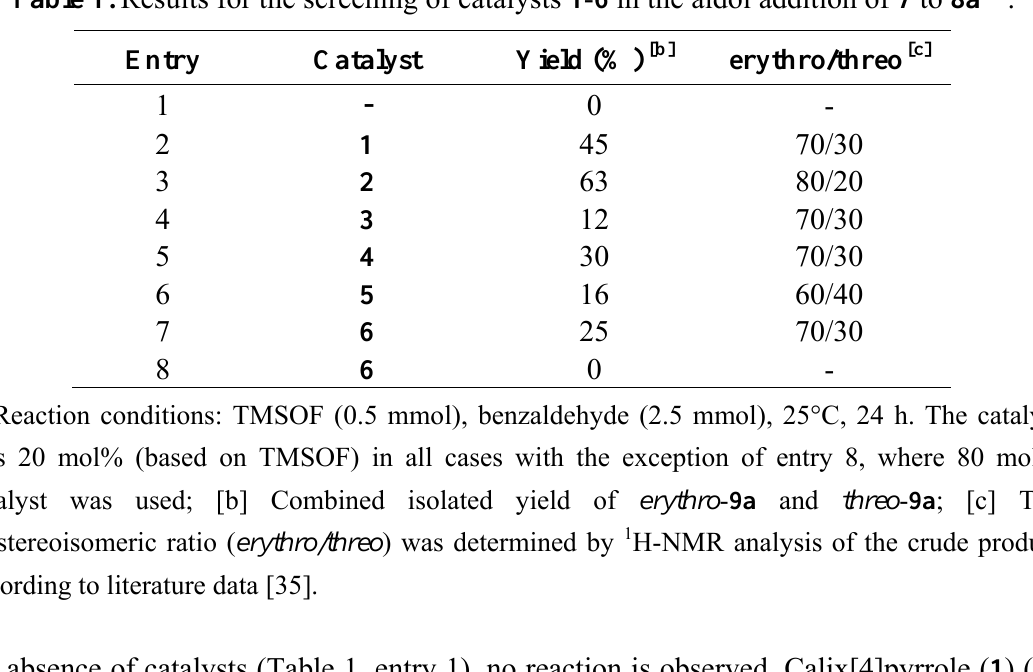
Table 1. Results for the screening of catalysts 1 - 6 in the aldol addition of 7 to 8a [a]